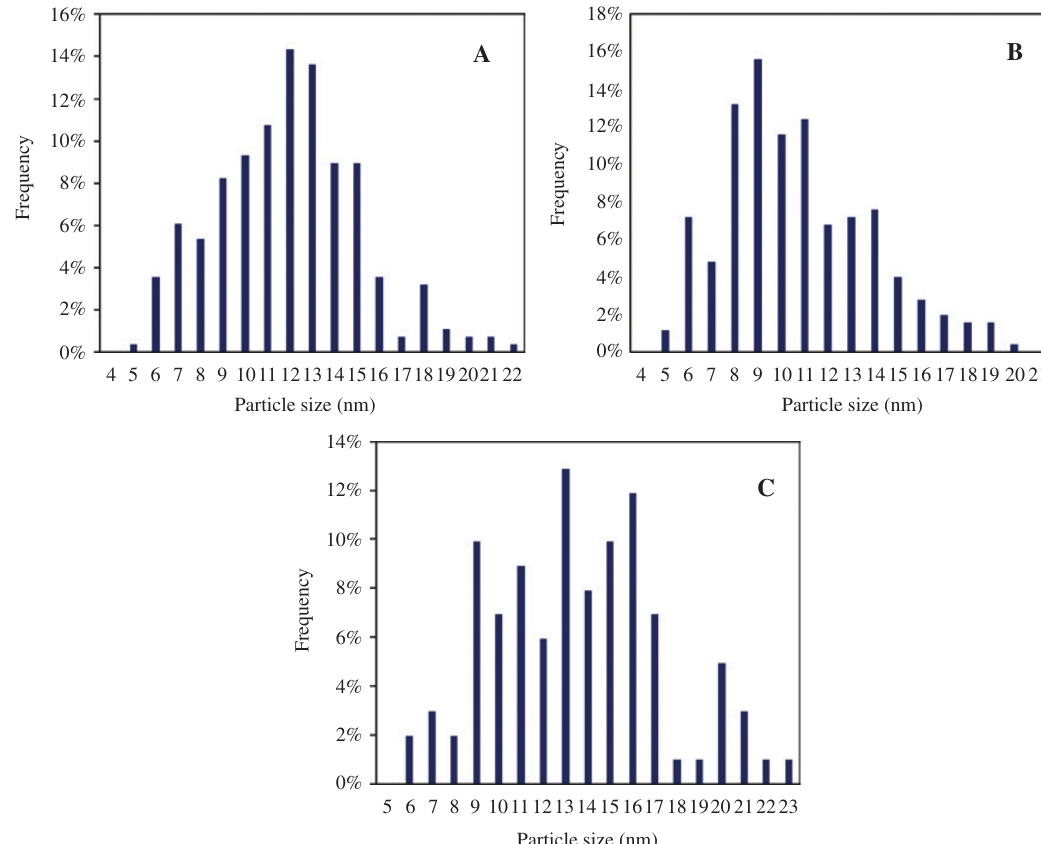
Figure 3: Particle size distribution of (A) Ag nanoparticles, (B) Au nanoparticles and (C) Ag-Au bimetallic nanoparticles.